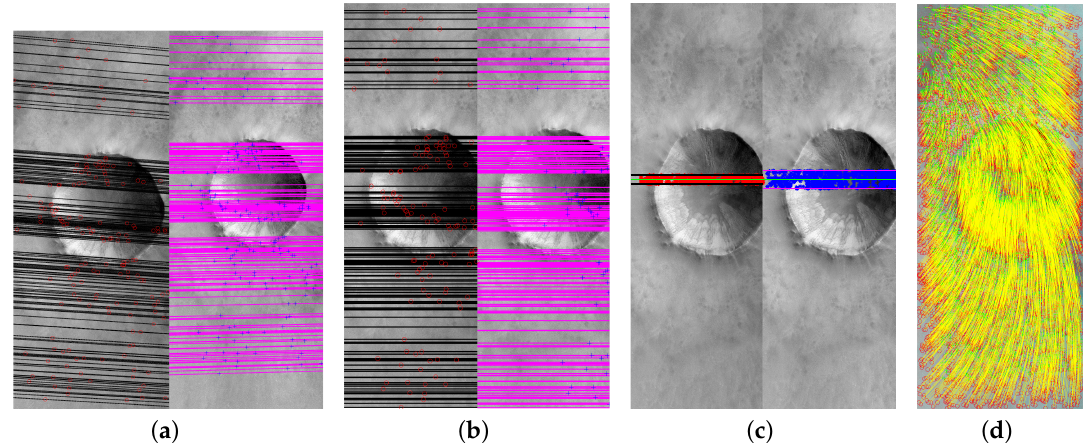
Figure 9. An example of minimizing the vertical-parallaxes of seed-matches, searching ranges and the dense matching result based on.the FD model. ( a , b ) the original and rectified epipolar lines of the initial seed-matches (black and magenta lines epipolar lines in the left and right images; red cyles and blue crosses in ( a ) are In and In (cid:48) , in ( b ) are (cid:99) In and (cid:99) In (cid:48) ). ( c ) An example of a local matching (the green line is the searching line, the area between black lines and the area between magenta lines represent a certain searching area). ( d ) An example of dense feature-matching results (7247 matched correspondences in this case; red cycles, blue crosses and yellow lines represent the resulting correspondences of U and U (cid:48)